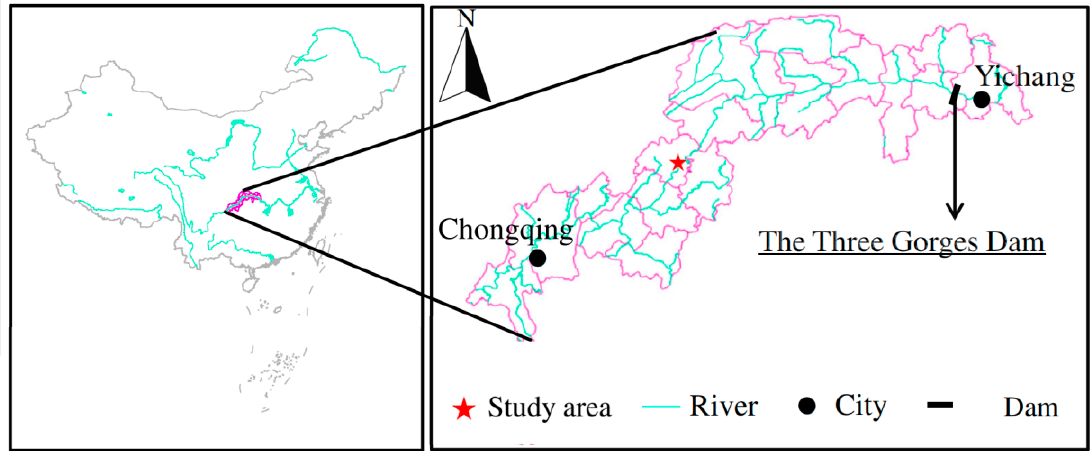
Figure 1. Location of sample site in the riparian zone of the Three Gorges Dam, China.